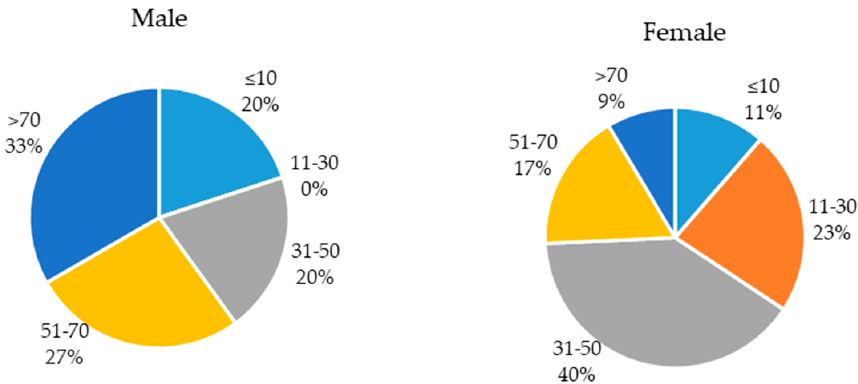
Figure 1. Age distribution of patients in relation to gender.